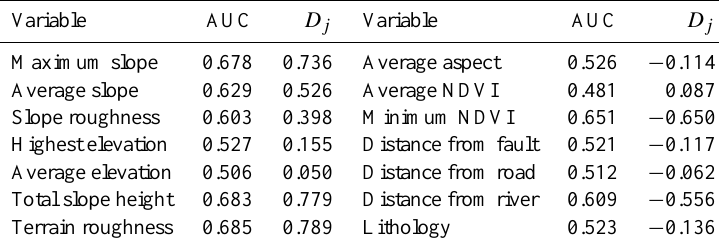
Table 2. The AUC value and D j for each